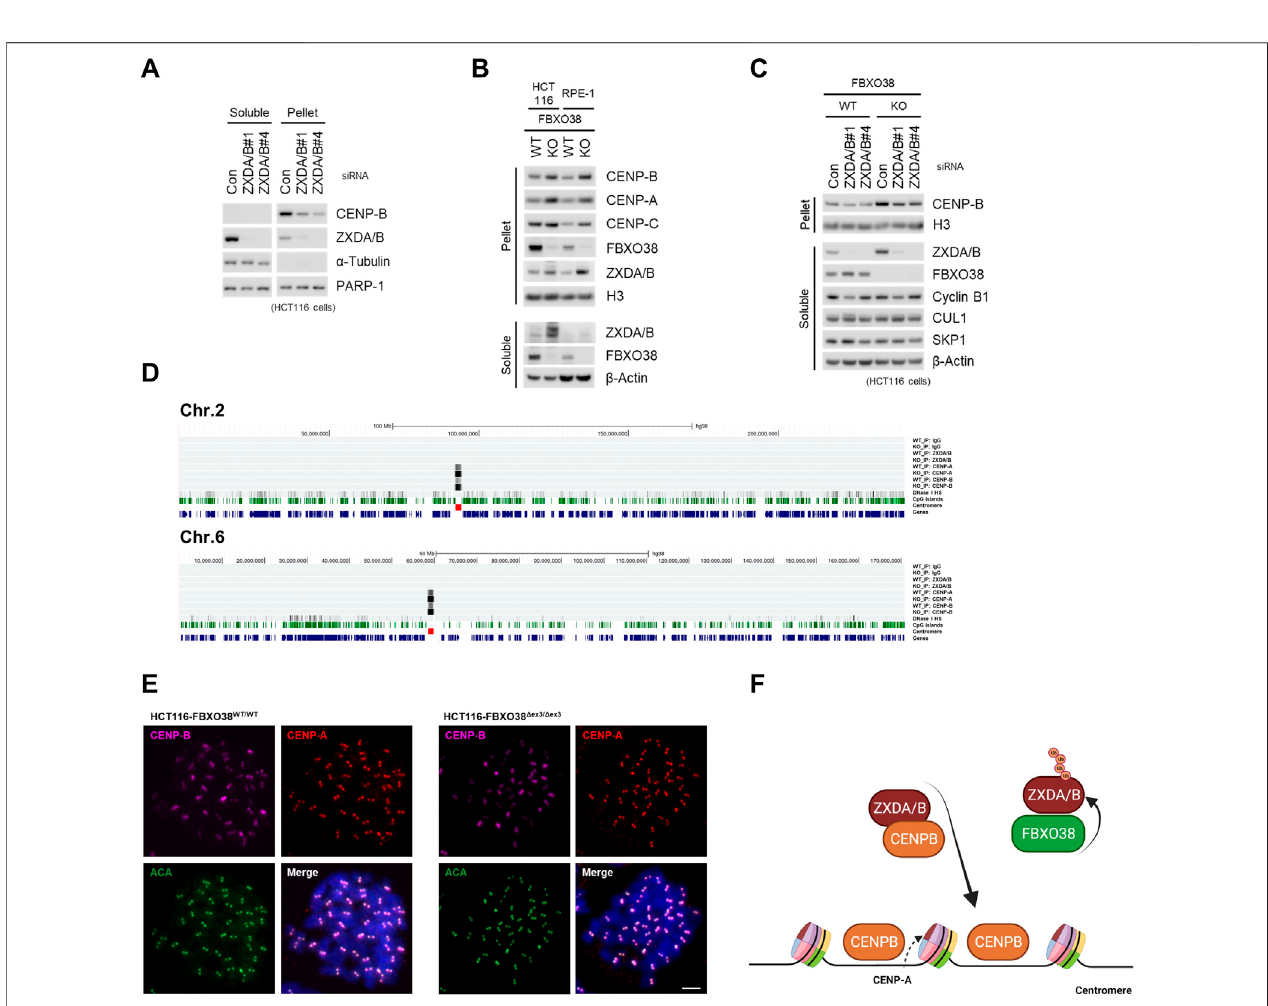
FIGURE 6 | FBXO38 controls centromeric signature via ZXDA/B stability. (A) HCT116 cells were transfected with two different siRNAs targeting ZXDA/B, or with control siRNA. The cells were subjected to isotonic lysis 48 h after transfection, soluble fractions were collected and the pellets were further lysed in the presence of Benzonase nuclease and subsequently heat denatured in the presence of 1% SDS for insoluble fractions. Lysates were immunoblotted as indicated (B) FBXO38 wild type (WT) and knockout (KO) HCT116 or RPE-1 cells were subjected to fractionation as in (A) and immunoblotted as indicated. (C) FBXO38 WT and KO HCT116 cells were transfected with two different siRNAs targeting ZXDA/B, or with control siRNA, lysed and immunoblotted as in (A) . The longer exposure of CENP-B immunostaining isavailable as Supplementary Figure S6A . (D) ChIP-Seq analysis ofchromatin-bound proteinsin FBXO38 WT and KO HCT116 cell line. Fragmented chromatin was immunopuri fi ed with either non-speci fi c IgG, or ZXDA/B, CENP-A, and CENP-B polyclonal antibodies. Trimmed reads were aligned using the Bowtie2 program and further normalized with bamCoverage utility (Galaxy — DeepTools) to obtain counts per million (CPM) values. Coverage of the human genome (hg38) was visualized in the UCSC genome browser. The fi gure shows two chromosomes (2 and 6) coverage with other chromosomes depicted in ( Supplementary Figure S6D ). The quantity of precipitated chromatin is shown as a density graph using autoscale to highlight the centromeric enrichment. The single lines below the chromosome range ruler represent ChIP results from IgG control, ZXDA/B, CENP-A, and CENP-B (in FBXO38 WT and KO HCT116 cells). These lines are followed by a density graph ofDNaseIhypersensitivity,CpGislands(green),centromere(red),andgeneslocations. (E) RepresentativeimagesofamitoticspreadofFBXO38WT(left)andKO(right) HCT116 cell line. The cells were pre-treated with colchicine and spun onto slides. Permeabilized cells were fi xed and immunostained with anti-centromere antibodies (ACA) and anti-CENP-A and CENP-B antibodies. Chromosomes were visualized with DAPI. Scale bar, 5 µm (F) Model of FBXO38-dependent regulation of the ZXDA/B protein. ZXDA/B proteins controls centromeric CENP-B protein level. FBXO38 is responsible for ZXDA/B degradation and limits CENP-B chromatin loading.